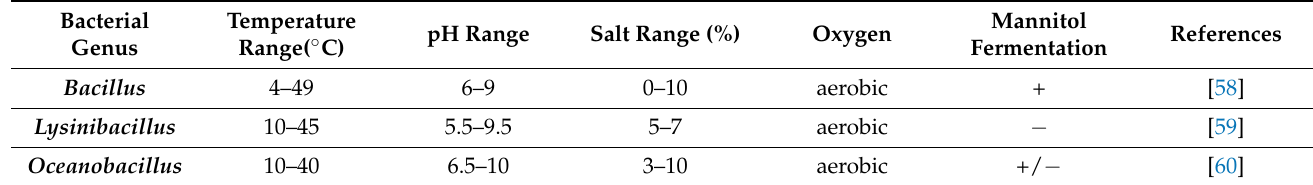
Table 5. Optimum growth conditions for the bacteria found in the samples